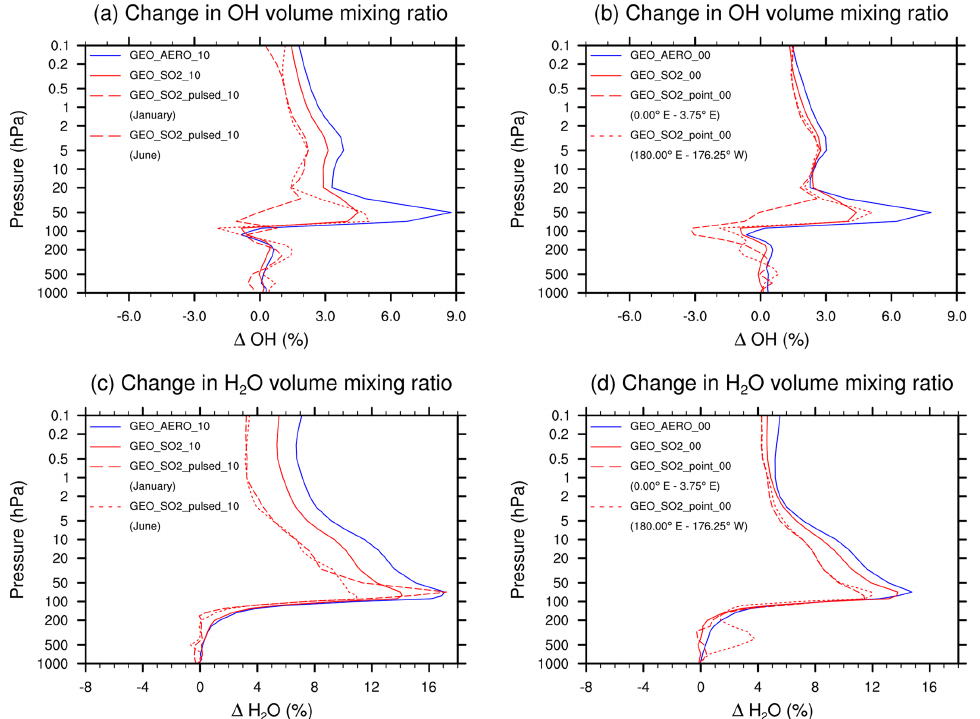
Figure 6. Vertical profile of the OH volume mixing ratio anomaly (a) and (b) , and H 2 O volume mixing ratio anomaly (c) and (d) . Anomalies represent prudential difference compared with the BACKGROUND simulation. Data show annual and zonal averages between 15 ◦ N and 15 ◦ S except where indicated. The left column, (a) and (c) , shows results for injections within 10 ◦ of the Equator, whereas the right column, (b) and (d) , shows results for injections at the Equator. For equatorial injections ( (b) , (d)) , we show results averaged from 0 to 3.75 ◦ E and from 180 ◦ E to 176.25 ◦ W. For the 10 ◦ injection case ( (a) , (c) ), we show zonal averages for January (emissions during 1 and 2 January) and June (month before emission) from the pulsed simulation. Note how SO 2 injection scenarios tend to reduce OH concentrations around 50hPa compared with AM H 2 SO 4 injection scenarios (due to the reaction SO 2 + OH = > SO 3 + HO 2 ), whereas both increase stratospheric H 2 O concentrations due to